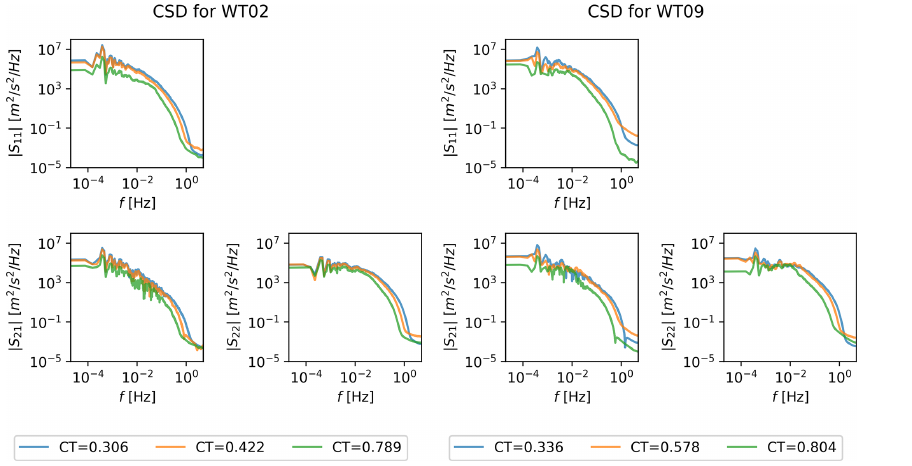
Figure 9. Norm of cross-spectral density of modal time series of the first two global POD modes for three C T values and for WT02 and